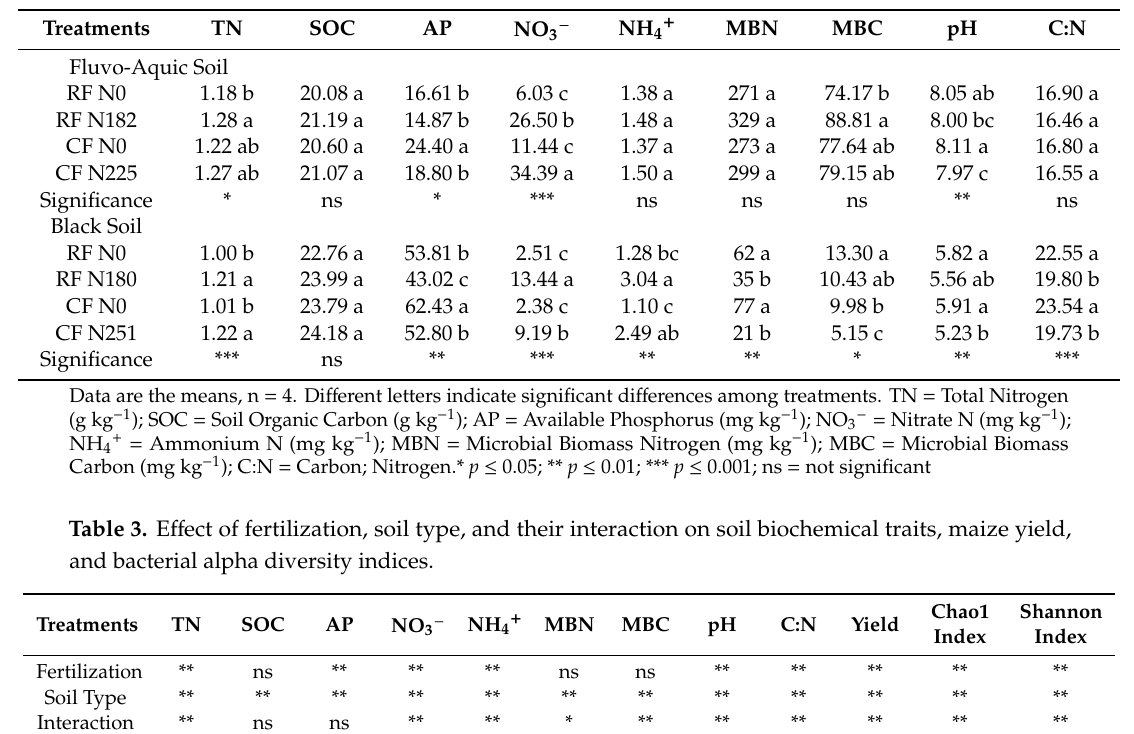
Table 2. Impacts of recommended and conventional fertilization regimes on soil chemical and biological properties.